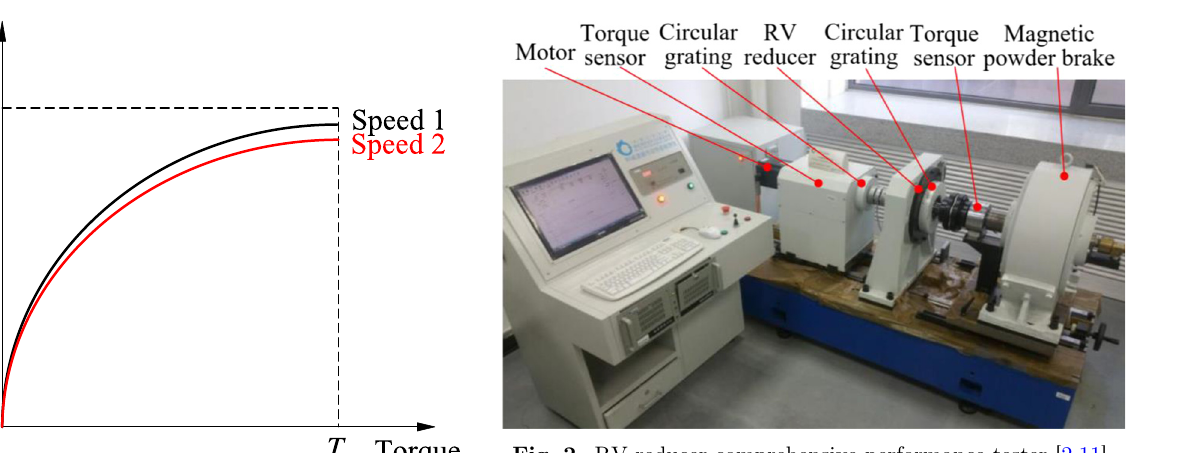
Fig. 2. RV reducer comprehensive performance